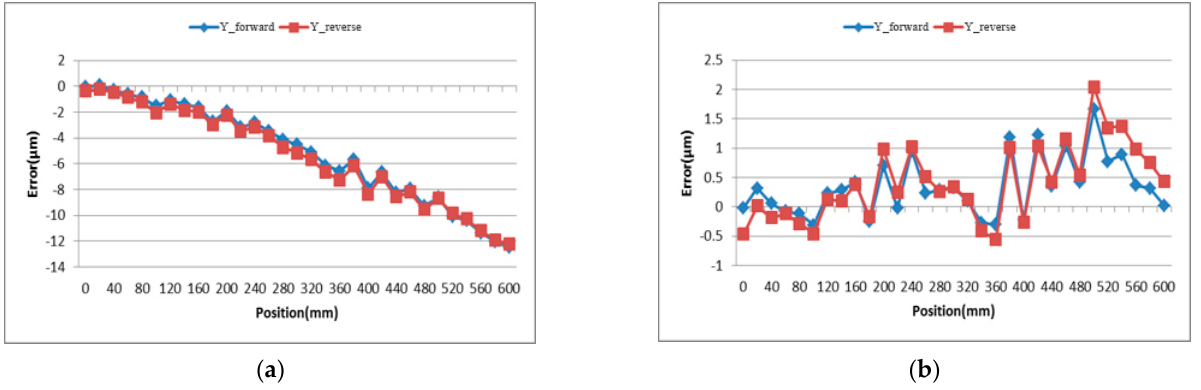
Figure 6. Compensation on the Y -axis: ( a ) results before compensation and ( b ) results after compensation.